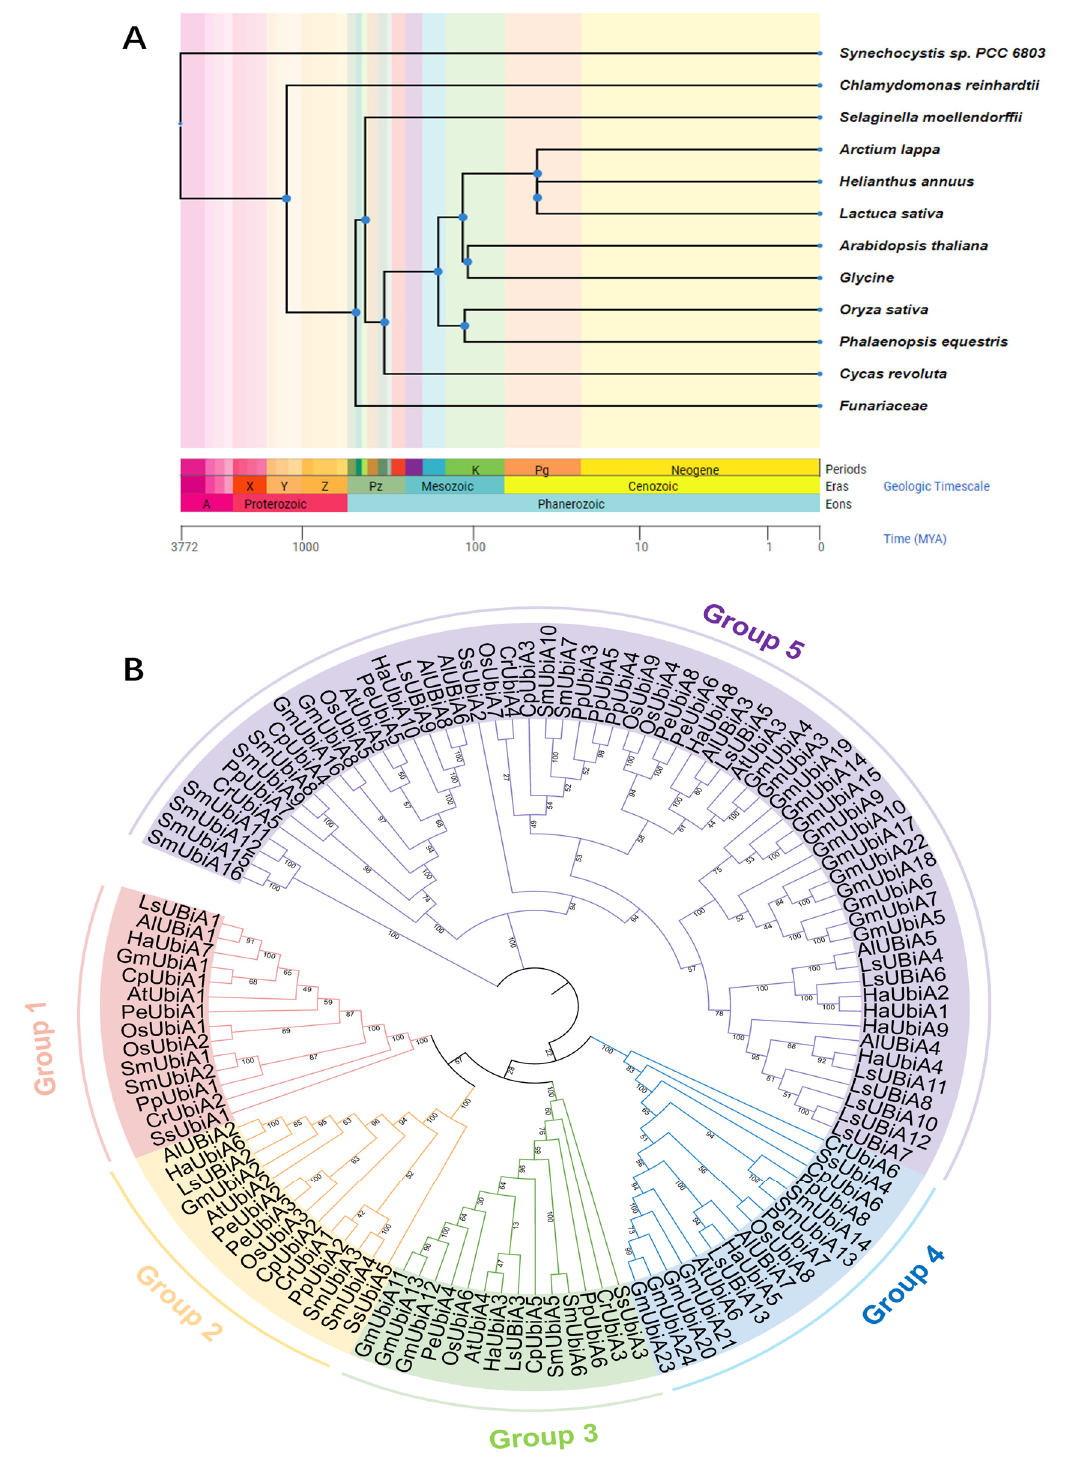
Figure 2. Species differentiation time and UBiA phylogenetic tree of 12 species. ( A ) The species time tree was constructed according to the origin time of 12 species. The colour blocks on the species time tree represent the geological time of their origin. ( B ) Phylogenetic trees of 12 species were constructed using MEGA7 by the neighbor-joining method with 1000 bootstrap replications. Each member cluster was labeled with different colors.